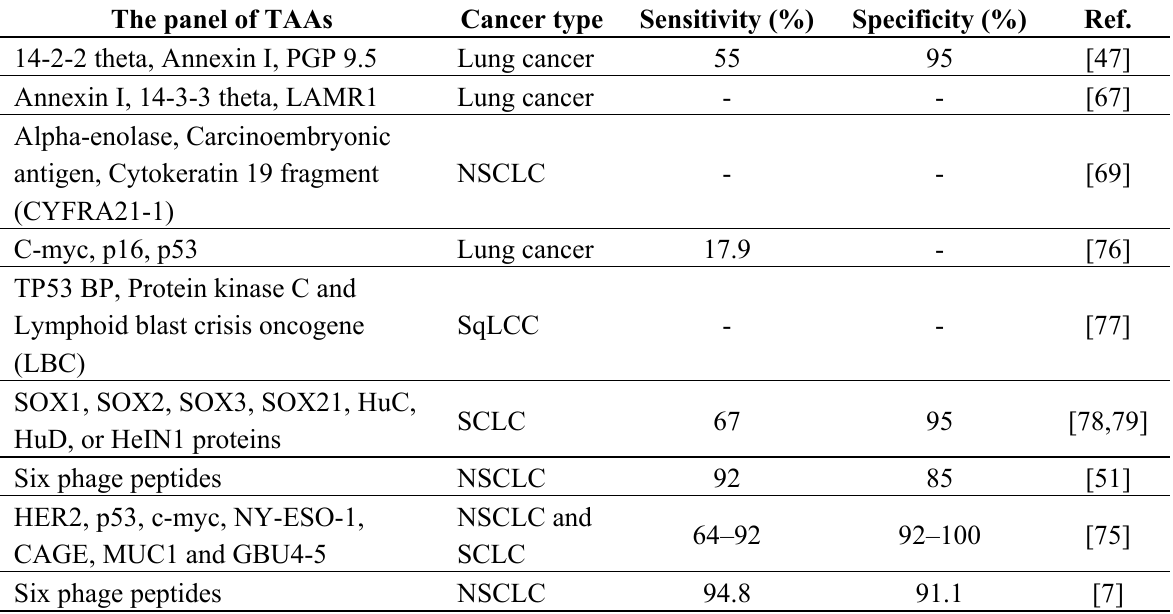
Table 1. Tumor-associated antigens (TAA) panels used for lung cancer diagnosis. Small Cell Lung